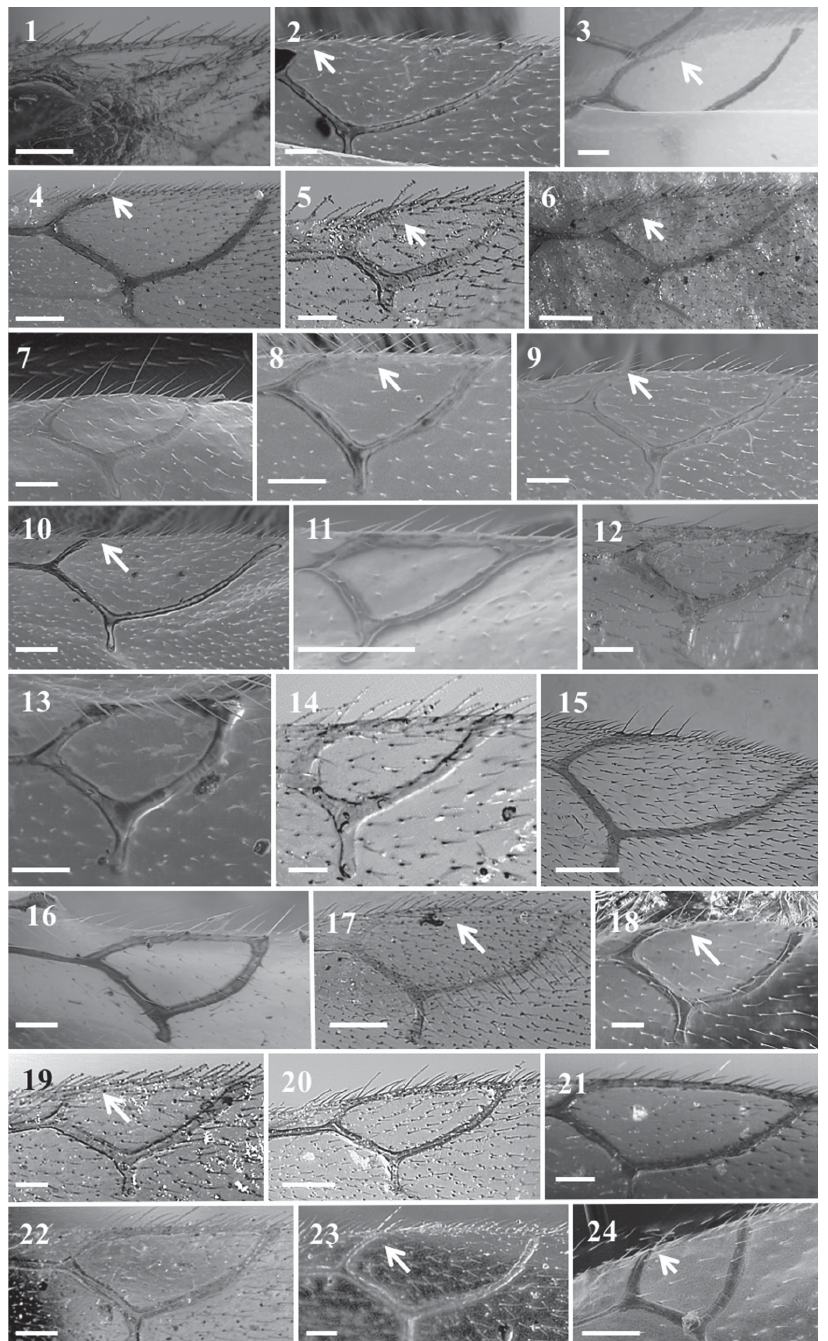
Fig. 5. Types of radial cell of Alloxysta Förster, 1869. 1 . A. nigricans Hellén, 1963. 2 . A.